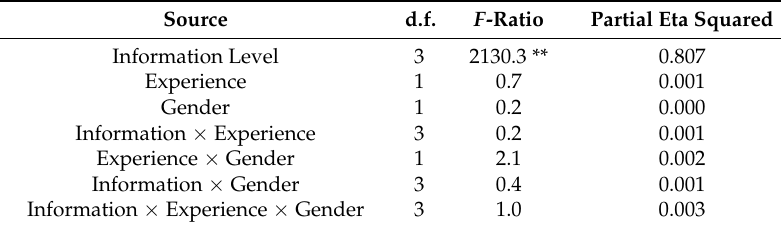
Table 3. Analysis of variance results for reaction